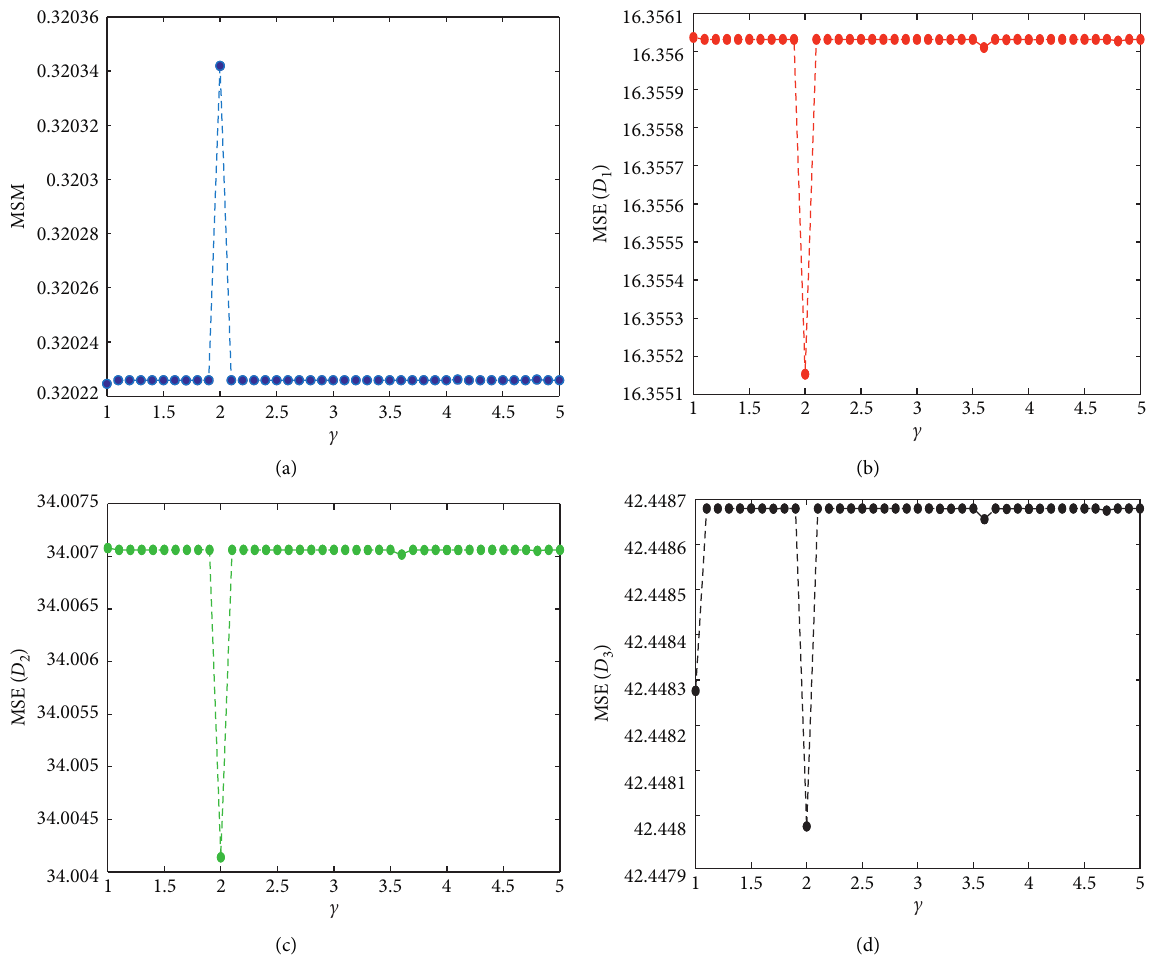
Figure 10: Goodness-of-fit measures for different values of c with three different distances D MSE index with distance D